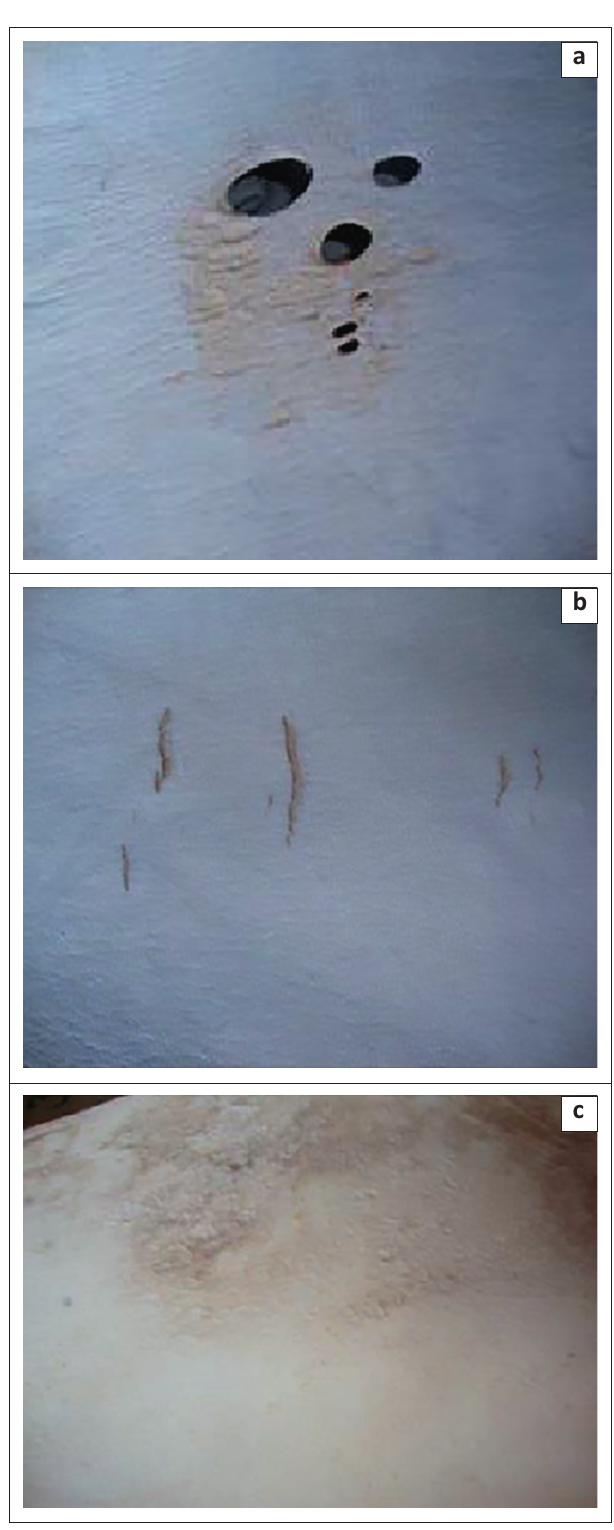
FIGURE 3: Post-slaughter defects seen in hides and skins: (a) holes and putrefaction; (b) grain crack and (c) beetle wet blue or dry goat skins and wet blue hides, respectively. Cracked grain resulted in rejection in 49.1 % wet blue or dry goat skin. Hide beetle damage caused downgrading or rejection of 25.2 % and 4.4 % of wet blue or dry goat skins and wet blue hides, respectively.